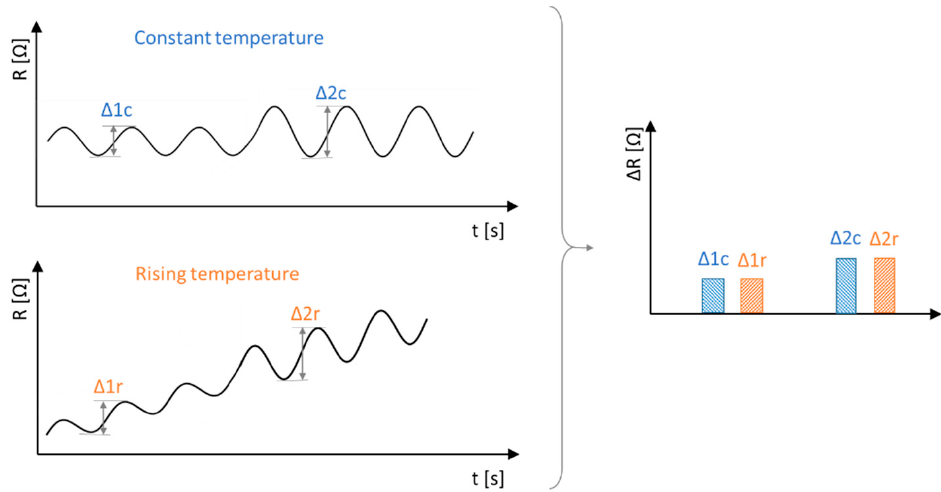
Figure 6. Evaluating the peak-to peak data.